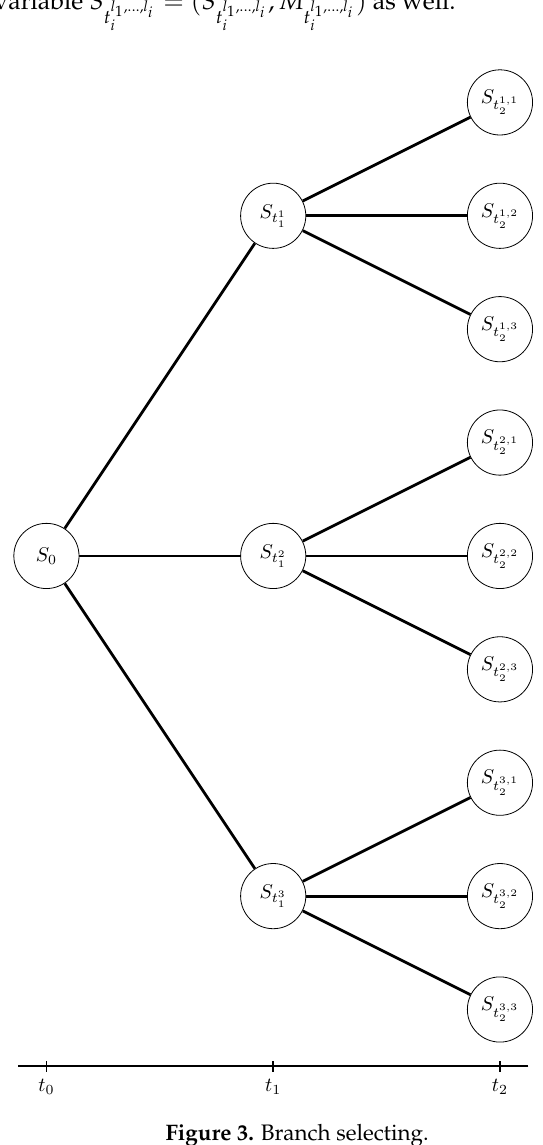
Figure 3. Branch